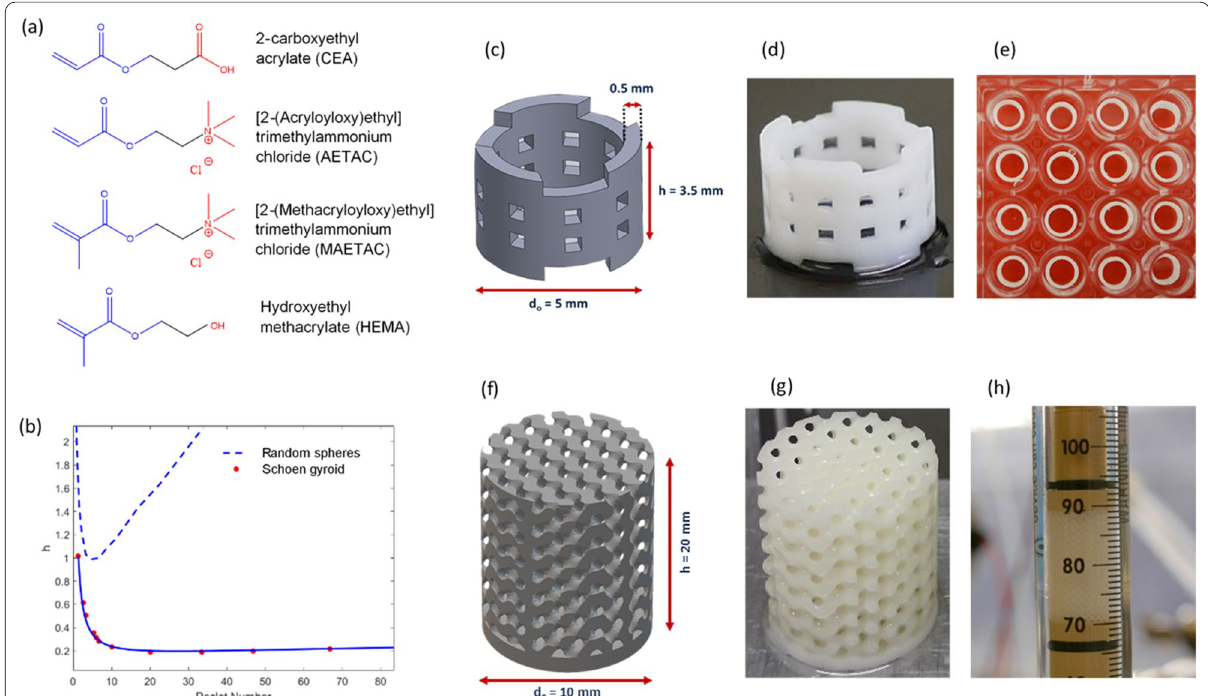
Fig. 1 Schematic flow diagram for the design, manufacture, and experimental testing of porous monoliths for applications in bioprocess engineering. a Chemical structures of bifunctional monomers (CEA, AETAC, MAETAC, HEMA) employed, displaying (meth)acrylate groups for polymerization (blue) and active groups (red). b Simulated reduced plate height vs reduced velocity (Peclet) for the gyroidal scaffold (this work) and random packing of spherical particles (extracted from Schure et al. 2004). c , f CAD models of hollow cylinder and gyroid structures, respectively, together their 3D printed counterparts ( d , g ). Experimental characterization of e hollow cylinders using 96 multi‑well plate set‑up in static (batch) mode and h gyroid scaffold in column for dynamic